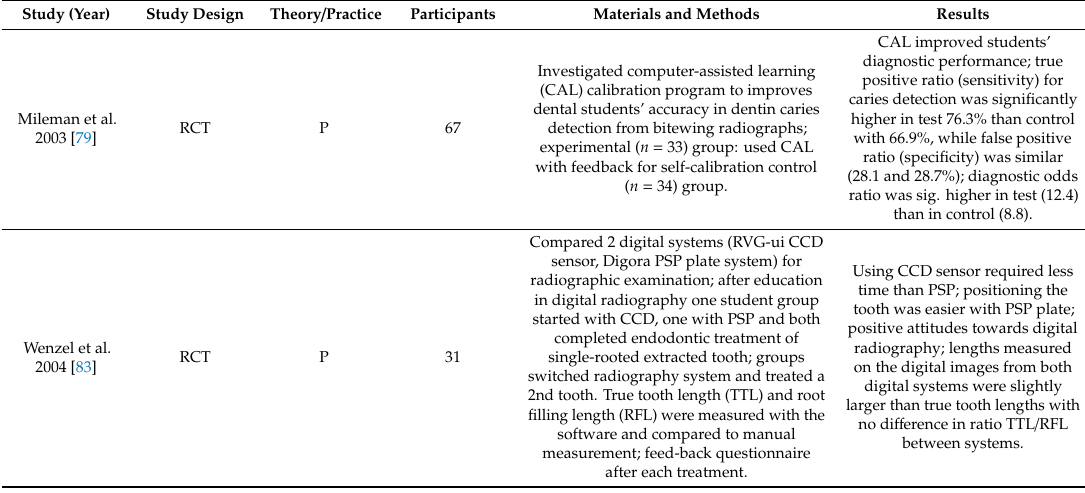
Table 5. Group 5: Digital Radiology ( n =